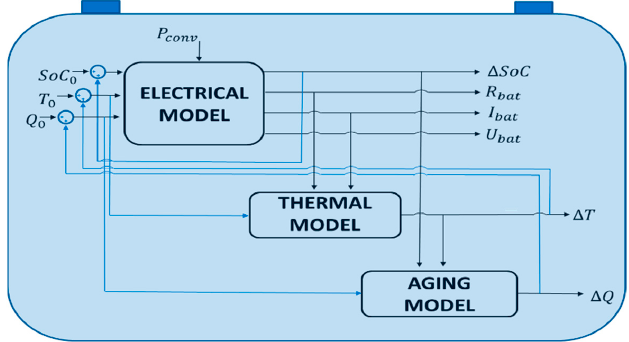
Figure 4. Battery coupled model.